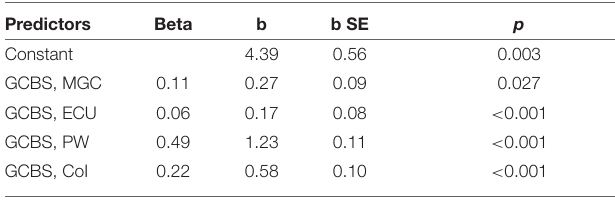
TABLE 4 | Regression model of belief in false information about the COVID-19 pandemic in the light of the tendency to believe in general conspiracy